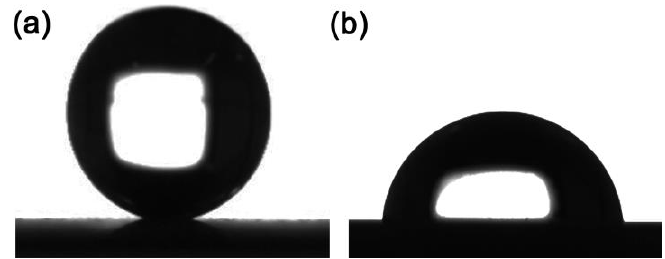
Figure 5. Contact angles of porous ( a ) and fully dense ( b ) CuNi films.